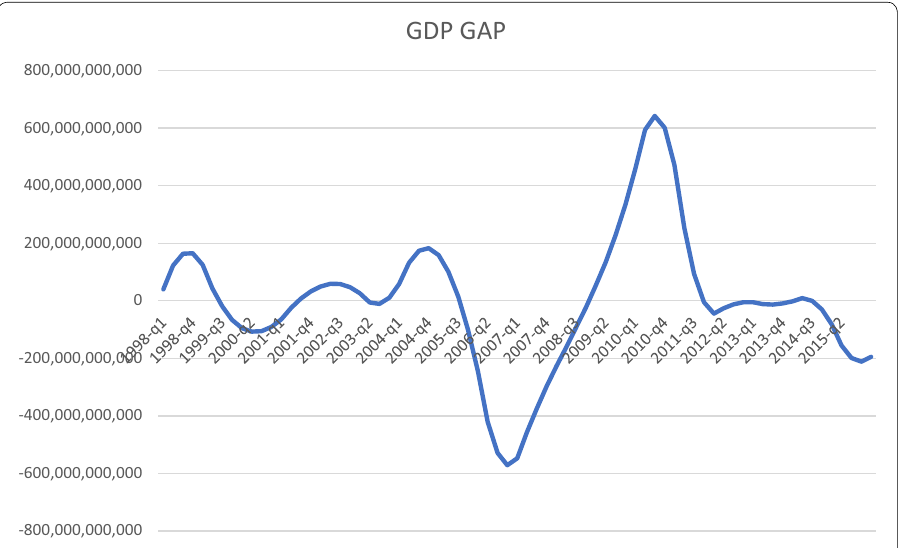
Fig. 3 GDP gap evolution since quarter 1‑1998 till quarter 4‑2015. Source : Prepared by author using the Hodrick Prescott filter based on data for real GDP collected from World Bank